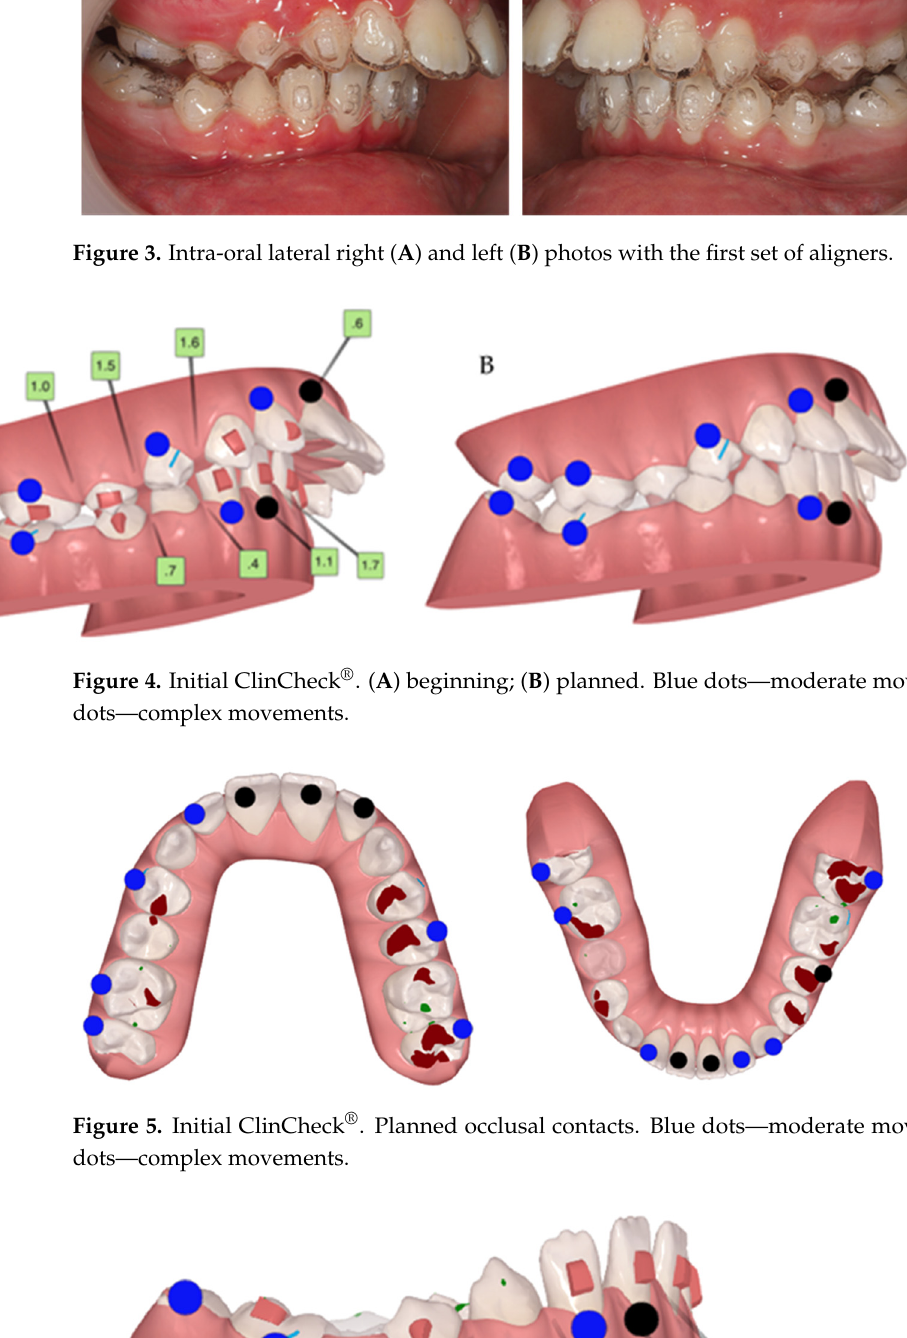
Figure 3. Intra-oral lateral right ( A ) and left ( B ) photos with the first set of aligners.